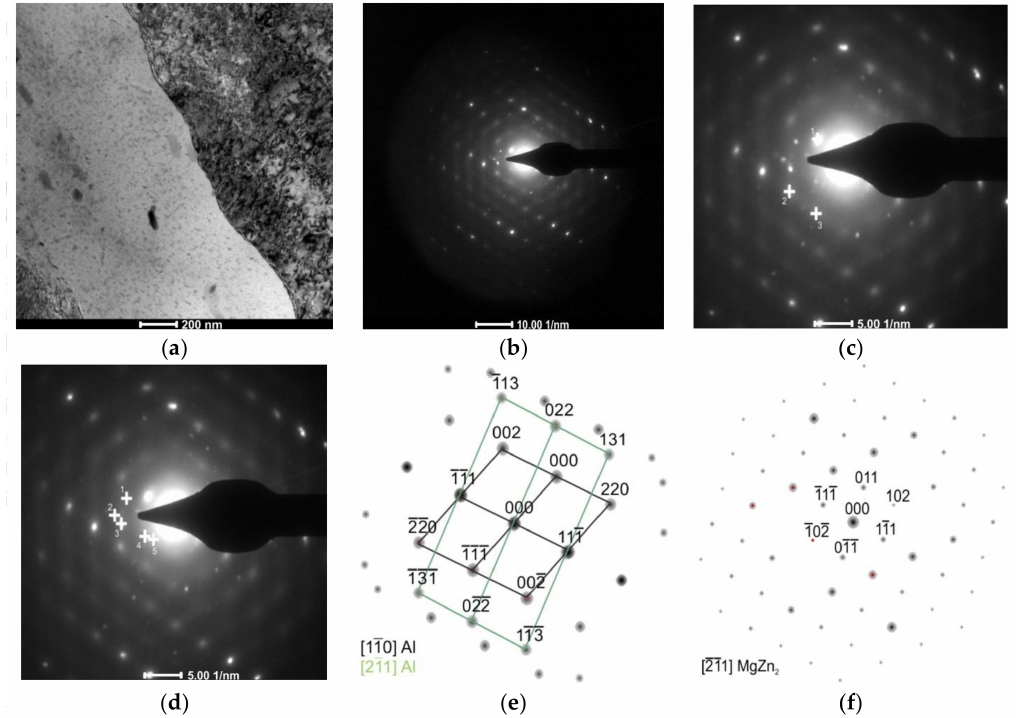
Figure 9. The AlZn6Mg0.8Zr alloy after LTTT with 30% deformation: ( a ) irregular subgrain boundaries; ( b ) electron diffraction; ( c ) marked reflections of α solution matrix; ( d ) marked reflections of MgZn 2 precipitate; ( e ) solution of α phase matrix diffraction and ( f ) solution of MgZn 2 phase